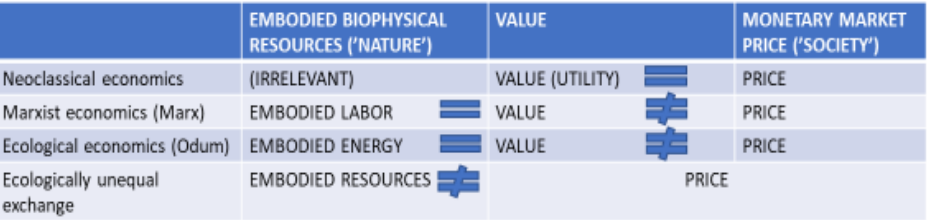
Fig. 1. The role of concepts of value in different schools of economic